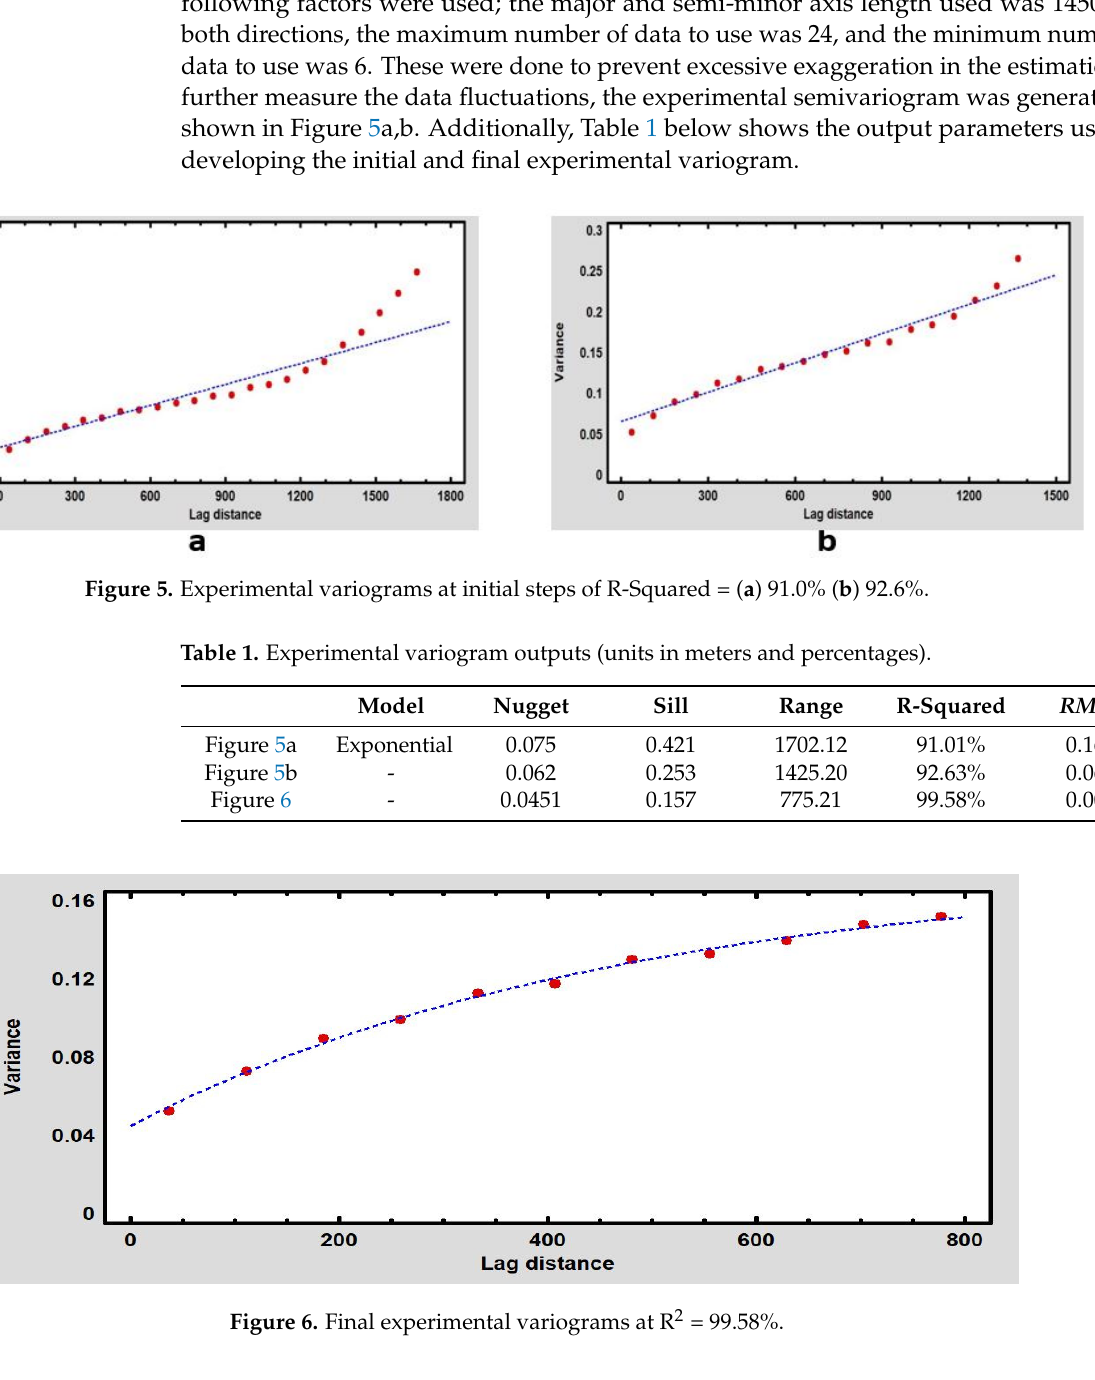
Figure 6. Final experimental variograms at R 2 = 99.58%.